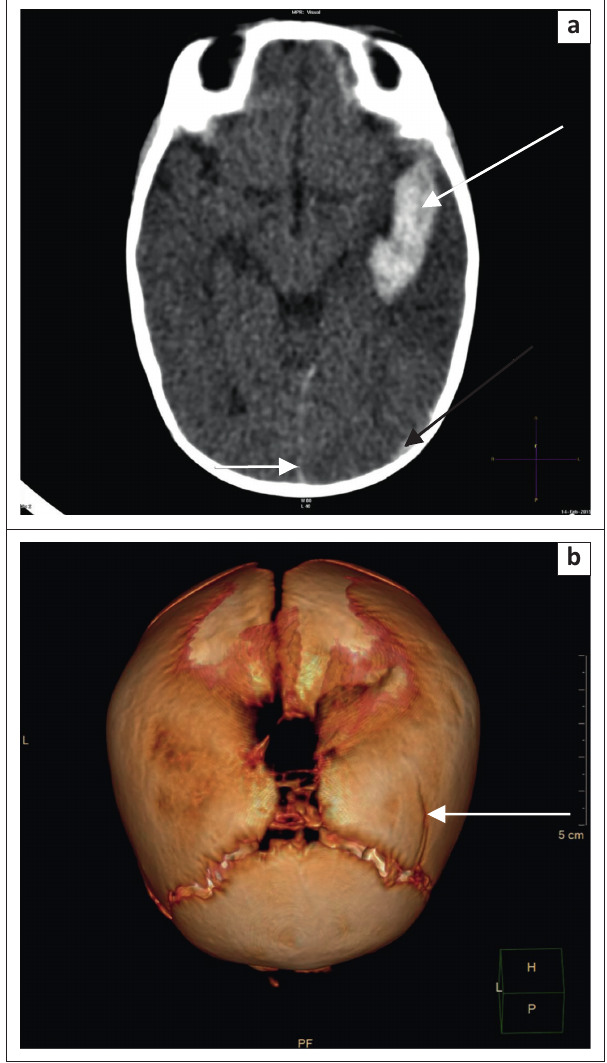
FIGURE 2: (a) A 2 month old male infant was referred with a history of focal seizures and suspected blindness. Axial CT brain demonstrated a large left temporal intracerebral haematoma (left white arrow). In addition there was a small acute left parieto-occipital subdural haematoma (black arrow) and blood in the posterior interhemispheric fissure (right white arrow). (b) 3D reconstruction demonstrated a contralateral parietal linear fracture (white